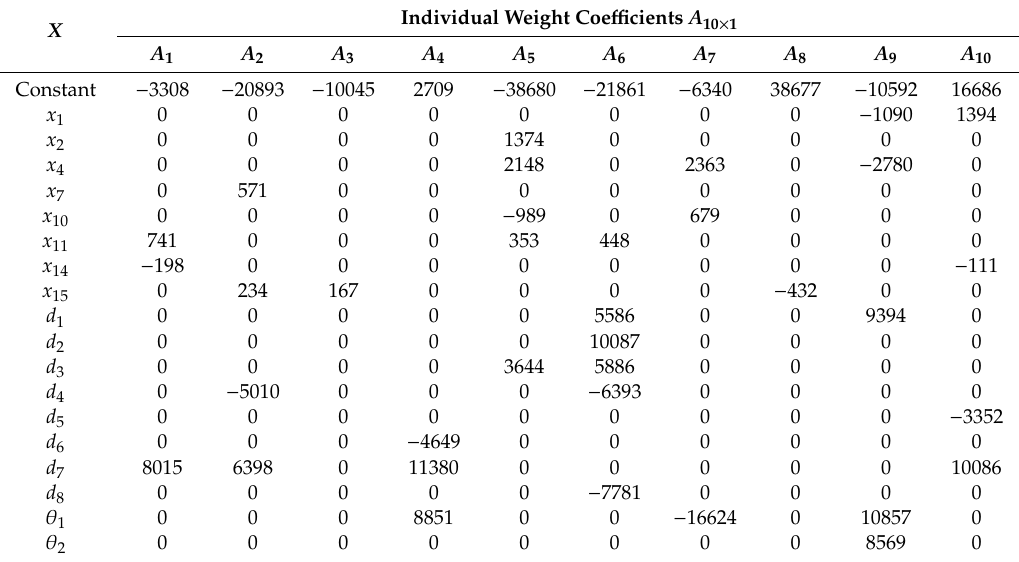
Table 4. Regression formula of our HRTF customization approach using anthropometric